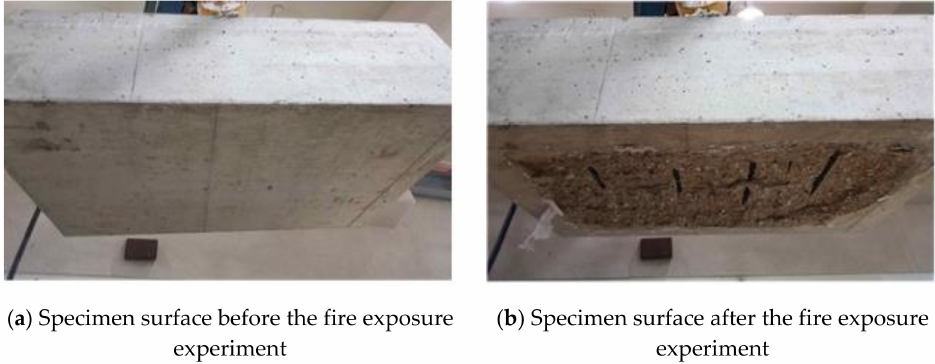
Figure 9. Specimen surface before and after the RABT-ZTV (highways) fire